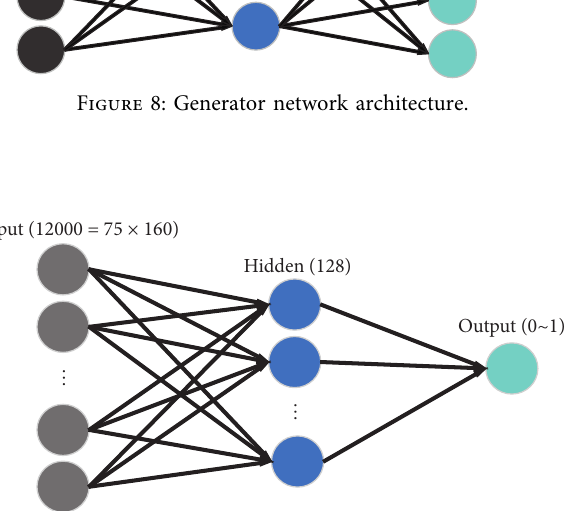
Figure 9: Discriminator network